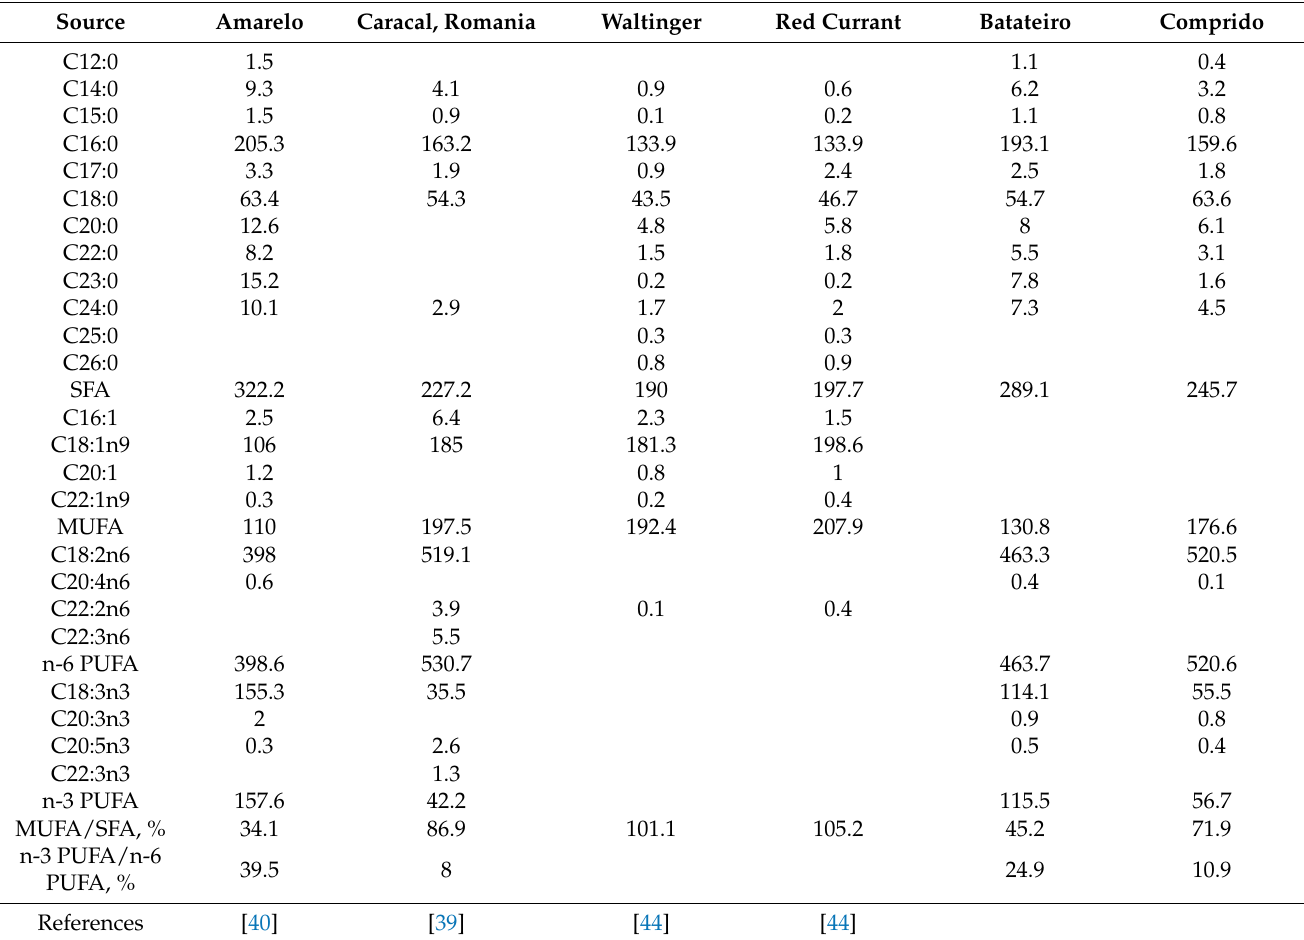
Table 4. Fatty acid composition of tomato pomace of different tomato varieties (g/kg dry matter